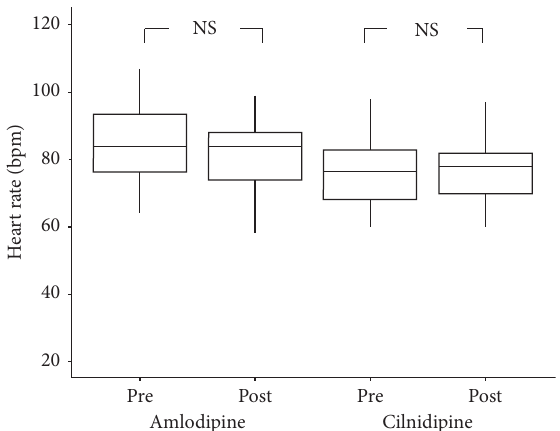
Figure 3: Changes in heart rate during the study period. Heart rate was almost the same between the cilnidipine and amlodipine groups and remained unchanged after 6 months of